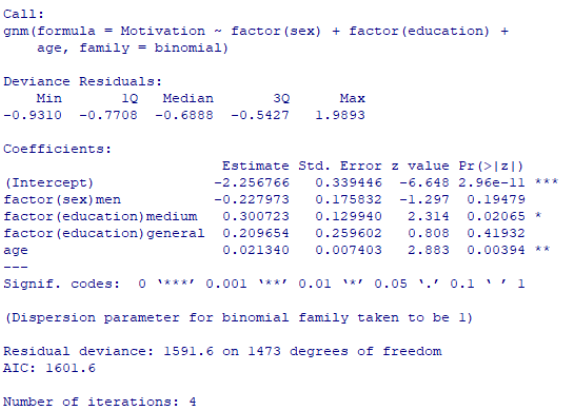
Figure 2. Generalized nonlinear regression model for motivation.